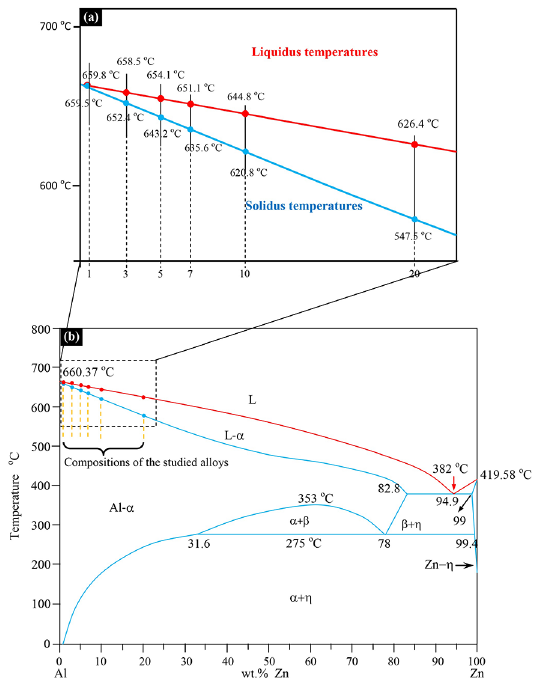
Figure 1. Phase diagram of Al-Zn system (a) partial view (studied compositions) (b) full view 7